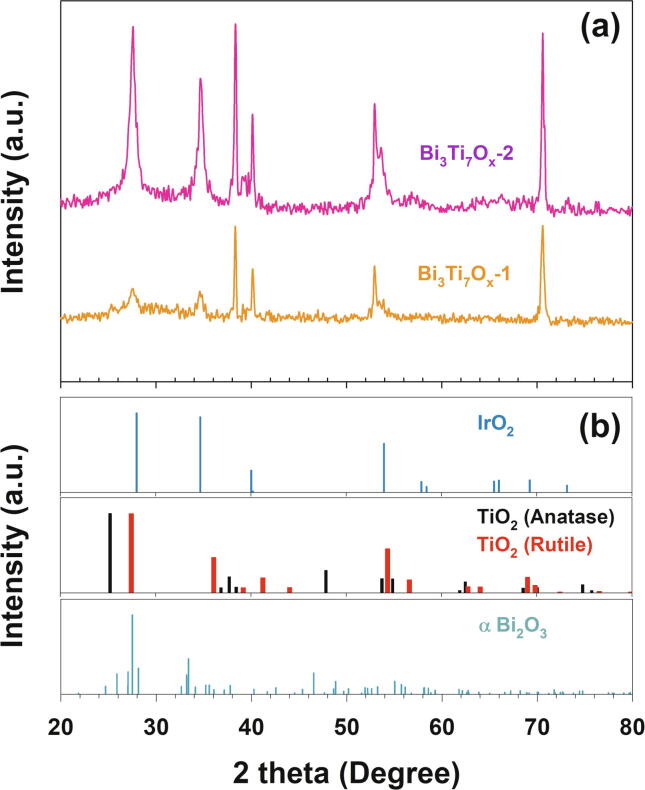
(a) X-ray diffraction patterns of (a) IrTaOy/(Bi3Ti7Ox-1, 2) heterojunction anodes, referenced with (b) IrO2, TiO2 (anatase, rutile) and α-Bi2O3.